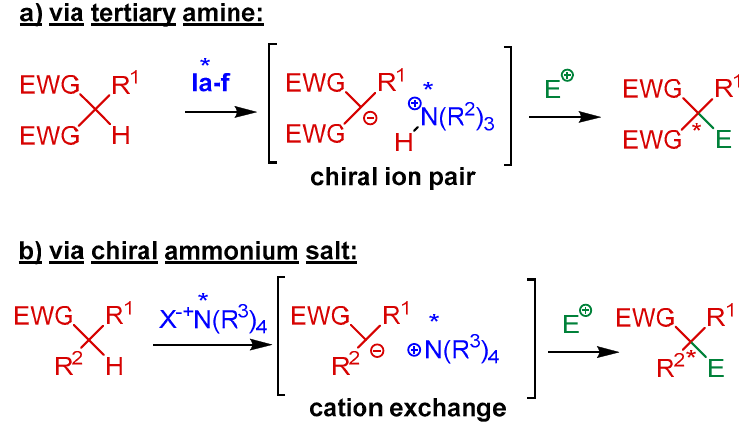
Scheme 27. Quinuclidinic proton quaternarization.